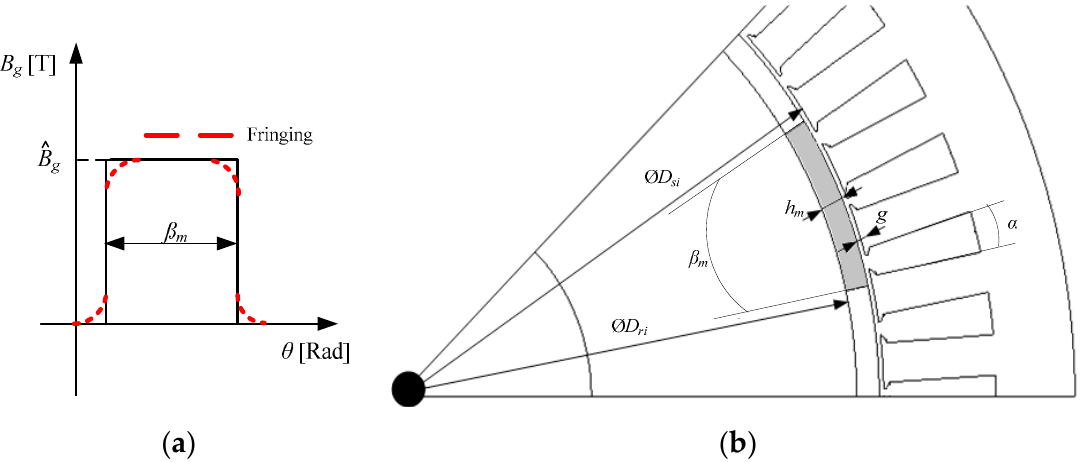
Figure 3. ( a ) Spatial distribution of the field with a and without a ; ( b ) main mechanical dimensions of the machine.